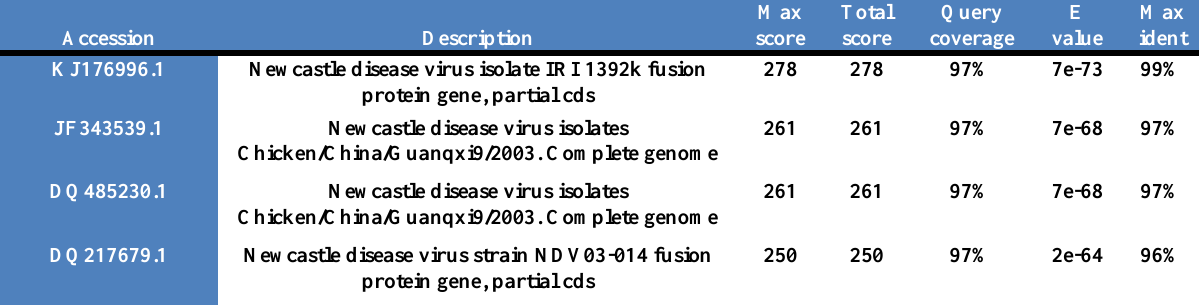
Table, 2: sequencing analysis of field NDV isolate in Iraq (Chicken/Broiler/Baghdad/2016) For comparison with high-related identity by use of blast software